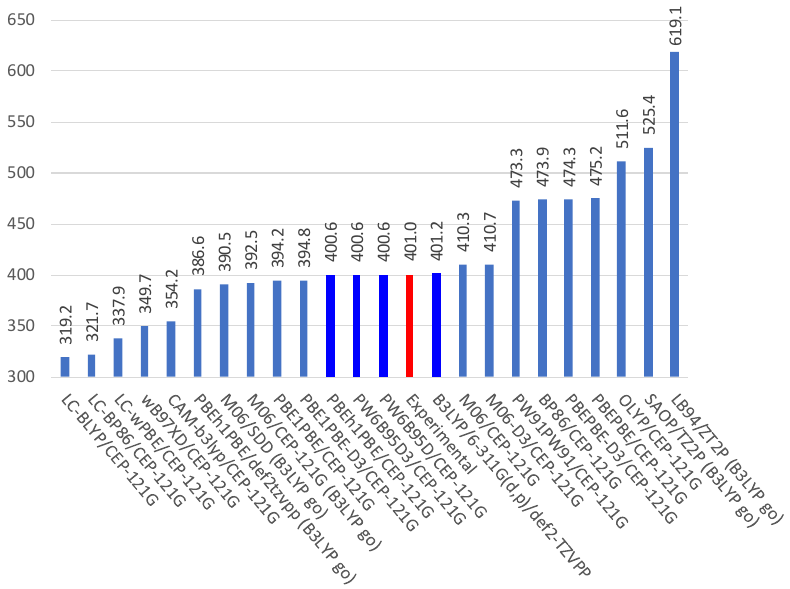
Figure 3. Calculated absorbance maxima (nm on y -axis) in the region 320–620 nm using the indicated DFT method ( x -axis), compared to the experimental absorbance maxima 401.0 nm of Cu(HBP) 2 ( 5 ), indicated in red. DFT methods in best agreement with experiment are shown in dark blue. The DFT methods used are indicated as functional/basis1/basis2 where functional is the DFT functional used, basis2 is the basis set used for Cu, and basis1 is the basis set used for C, H and O. If no basis2 is indicated, basis1 is also used for Cu. The five methods showing “B3LYP go” in brackets used the optimized B3LYP geometry in the TD-DFT calculation with the indicated method. For all the other methods, geometry optimization as well as TD-DFT calculations were done with the indicated method.